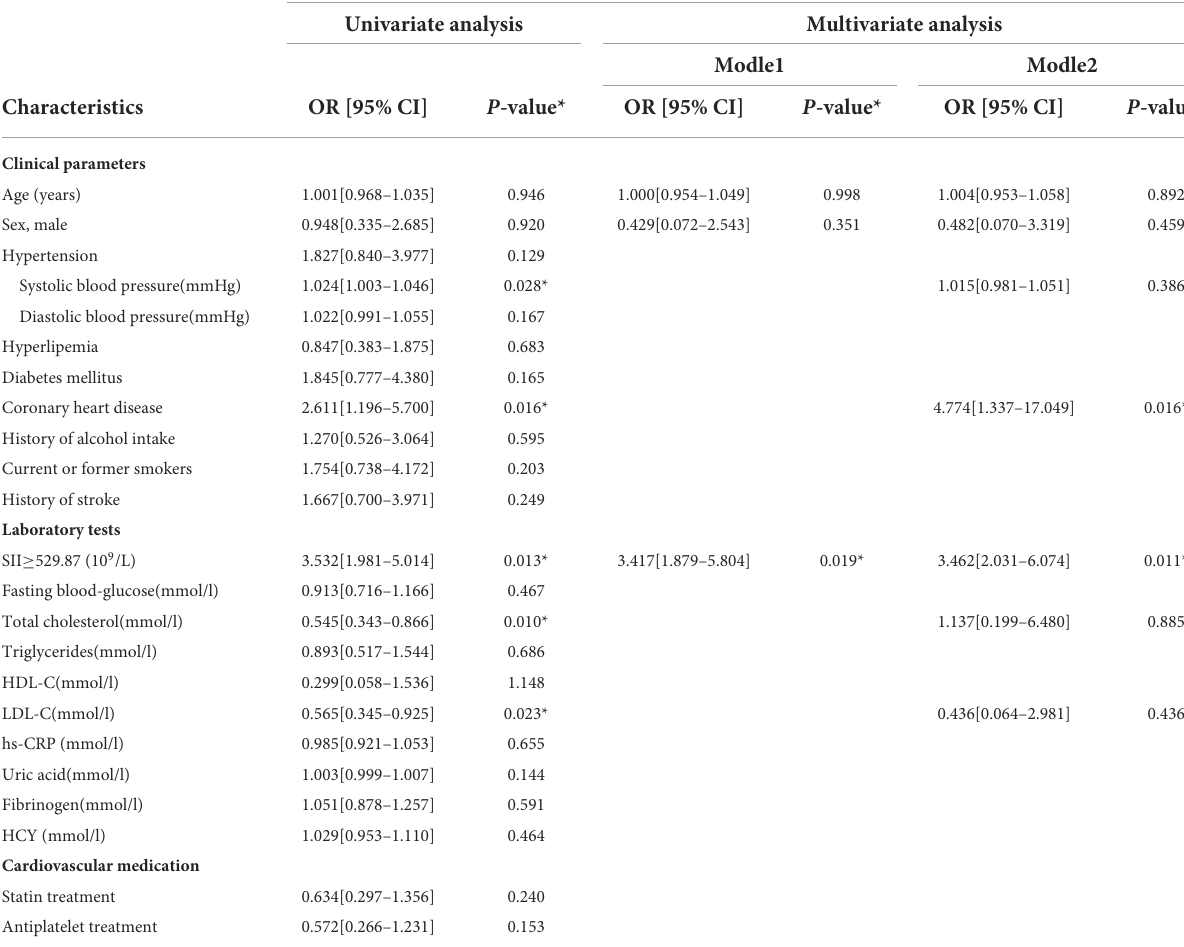
TABLE 4 Univariate and multivariate logistic regression analysis of factors related to ruptured fibrous cap ( N =